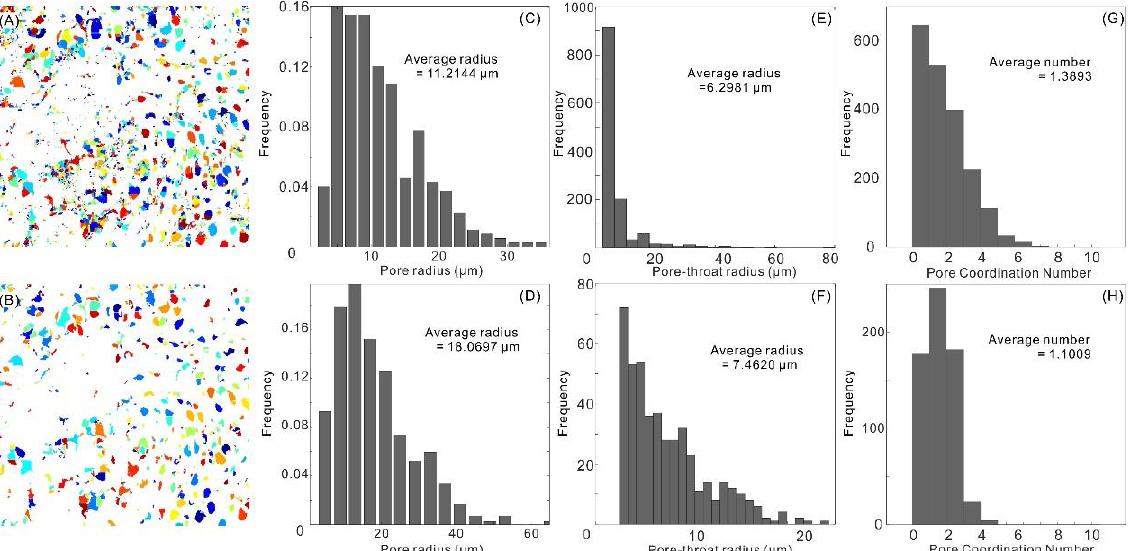
Figure 10. ( A ) The original pore unit segmentation; ( B ) Pore unit segmentation of the denoised binary image; ( C , D ) Pore radius distribution; ( E , F ) Pore-throat radius distribution; ( G , H ) Poor coordination number.